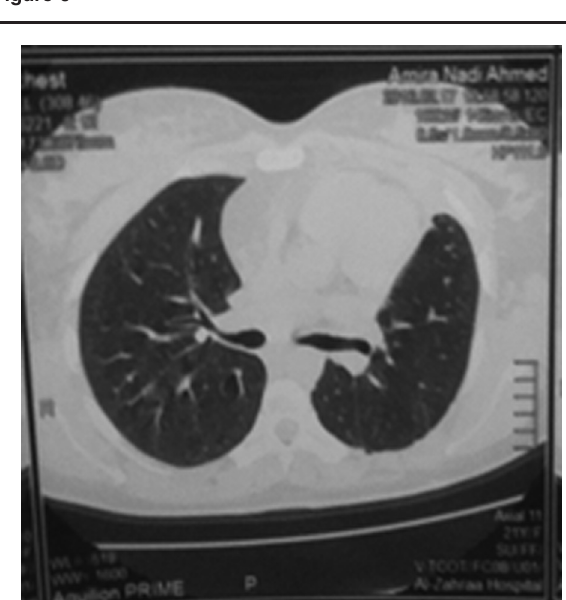
Cut of computed tomography (CT) of the chest (after 10 months).